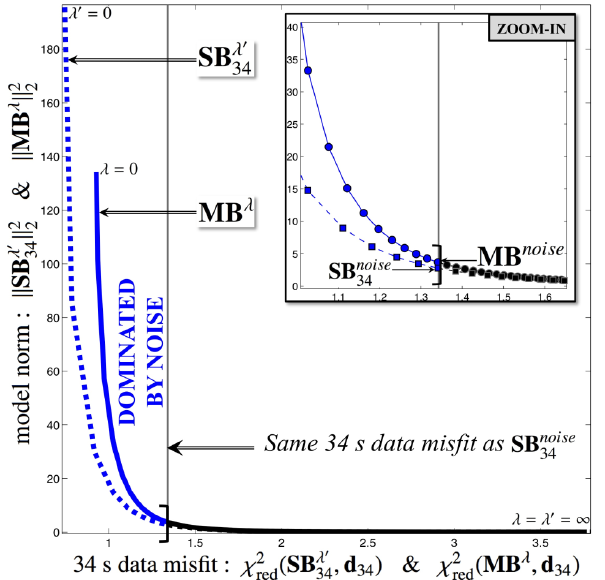
Fig. 4. Illustration showing how to infer multi-band models domi- nated by noise from single-band models. The curve of trade-off, be- 0 , tween model norm and 34s data misfit, is plotted for single- ( SB λ 34 dashed line) and multi-band ( MB λ , solid line) models. An accept- able multi-band model should not give a better fit to the 34s data ( d 34 ) than the single-band model SB noise . Thus, multi-band models 34 ( MB λ , d 34 ) ≤ χ 2 ( MB noise , d 34 ) are identified as “dom- with χ 2 red red inated by noise”. The multi-band model MB noise is defined as hav- ing the same 34s data misfit as SB noise 34